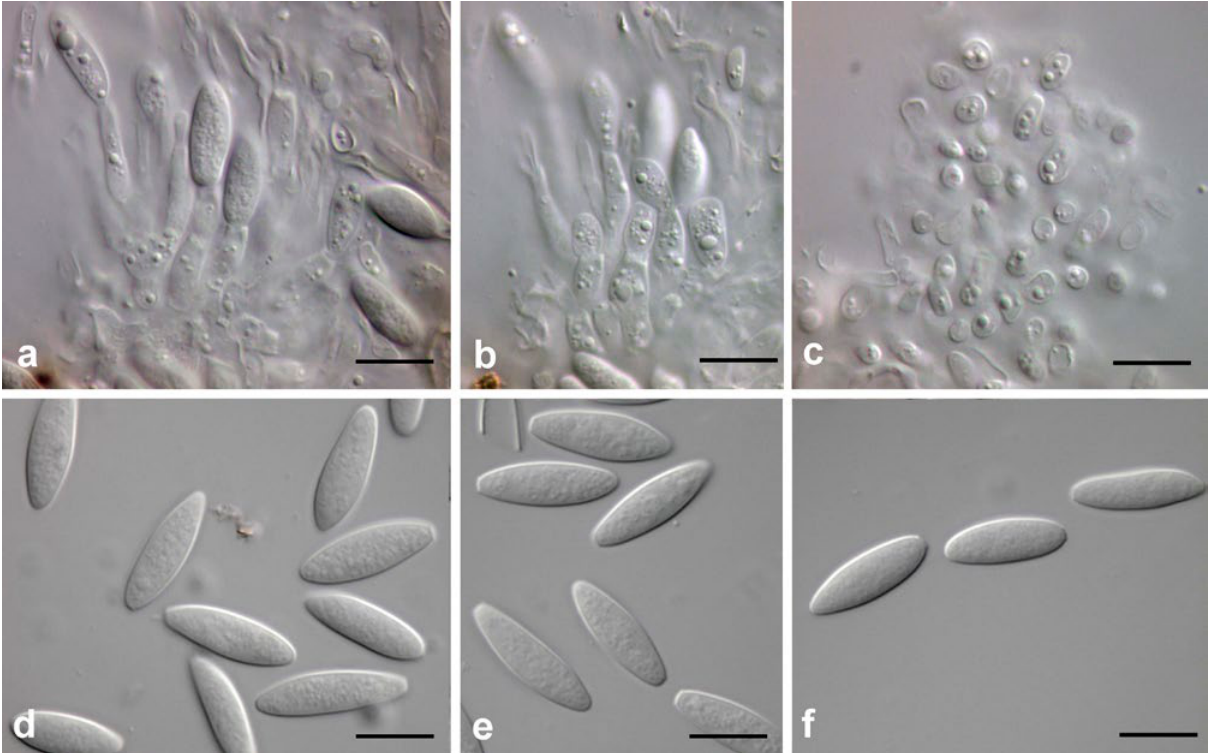
Figure 2. Neofusicoccum algeriense . a, b. Conidia developing on conidiogenous cells. c. Spermatia. d–f. Hyaline mature co- nidia. Bars: 1000